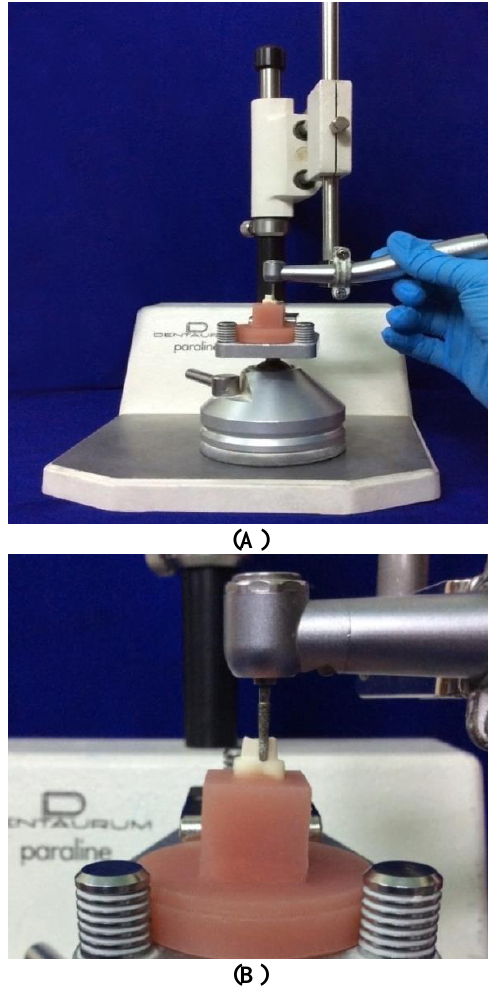
Figure 2: Finished prepared